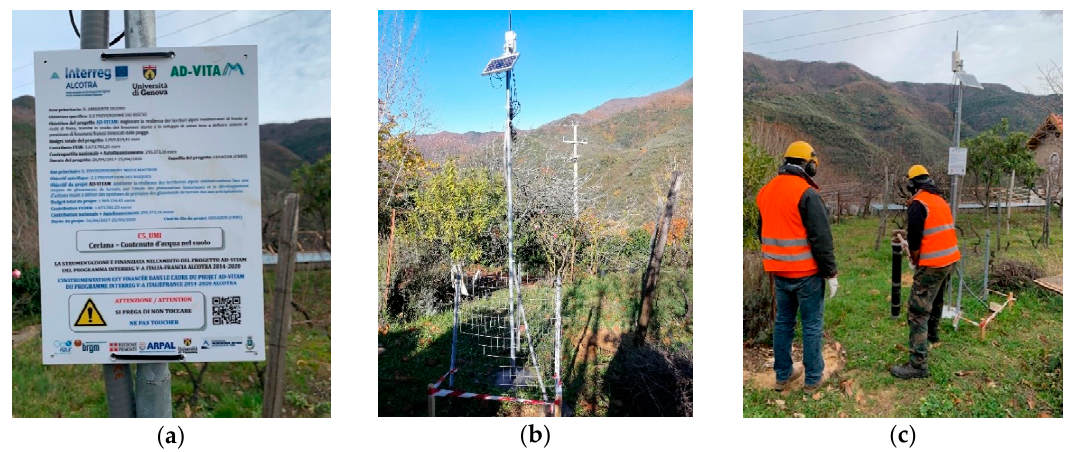
Figure 18. Ceriana-Mainardo: ( a ) Landslide perimeter view overlapped in 3D; ( b ) Geological map. The landslide perimeter (red polyline) and the nodes C1–C5 (red dots) are reported.